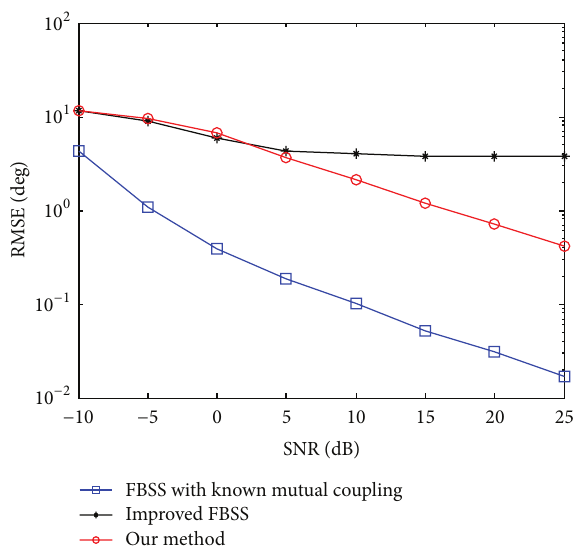
Figure 2: RMSE of DOA estimates against SNR ( 𝑁 𝑐 = 𝑃 = 2 ).